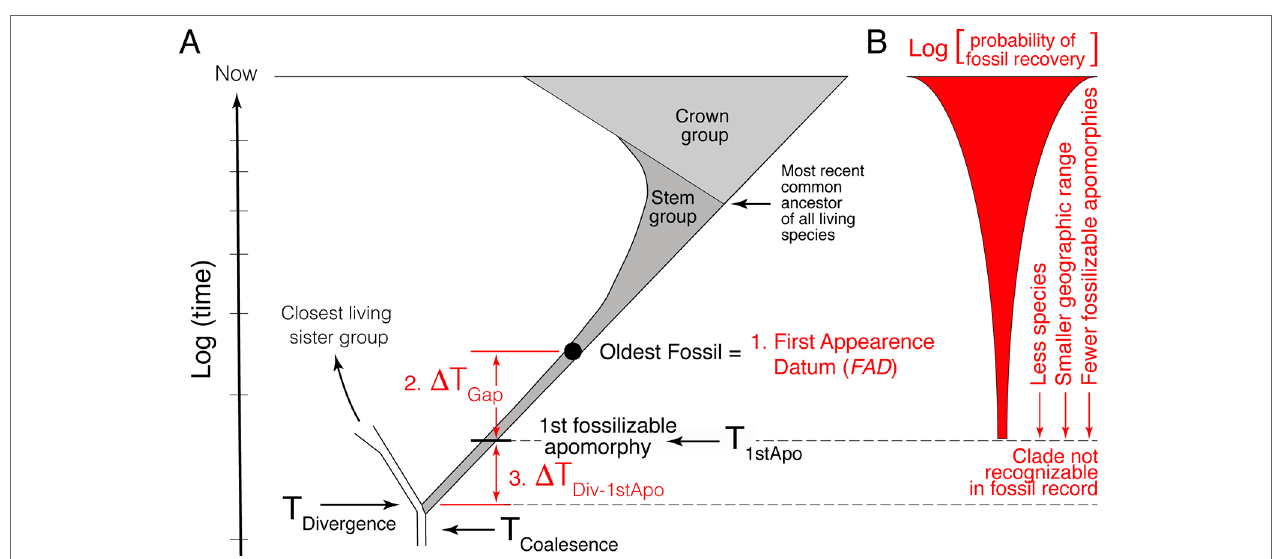
FIGURE 1 | Schematic representation of the challenges encountered when using the fossil record to estimate divergence time between lineages. (A) The three primary challenges are: 1) the easiest, identifying and determining the age of the oldest fossil ( FAD ); 2) estimating the size of the temporal gap between the FAD and the time of origin of the first fossilizable apomorphy of the lineage (ΔT Gap ); and 3) estimating the size of the gap between the true time of origin of the first fossilizable apomorphy and the actual divergence time (ΔT Div-1stApo ). ΔT Div-1stApo cannot be directly addressed with the fossil record because fossils that belong to this part of the clade’s history are not recognizable. (B) Estimating the size of ΔT Gap is made difficult by the fact that the probability of recovering fossils for most lineages decreases as one approaches its time of origin, as well as the fact that the fossil and rock records are idiosyncratically incomplete temporally and spatially (not depicted).